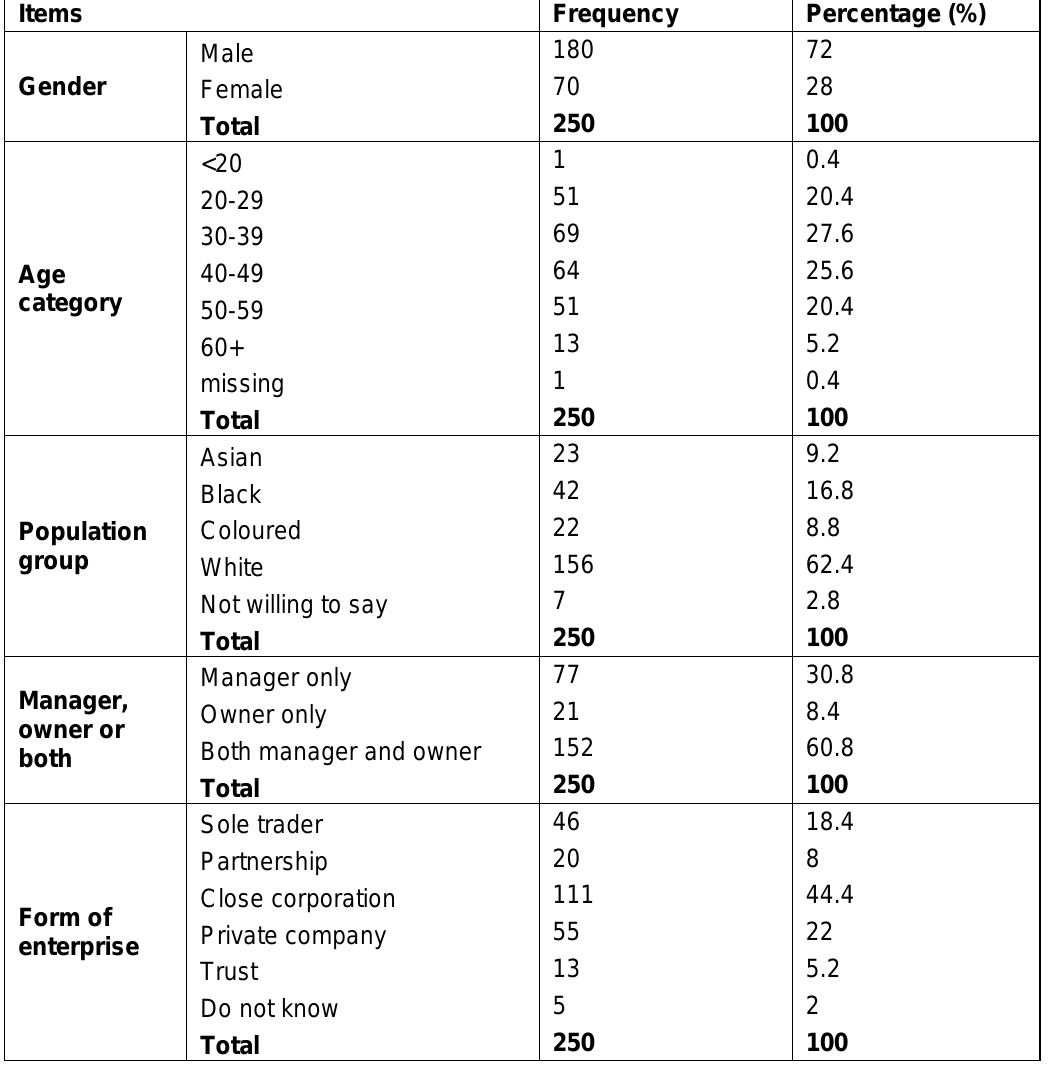
Table 1: Biographical data of